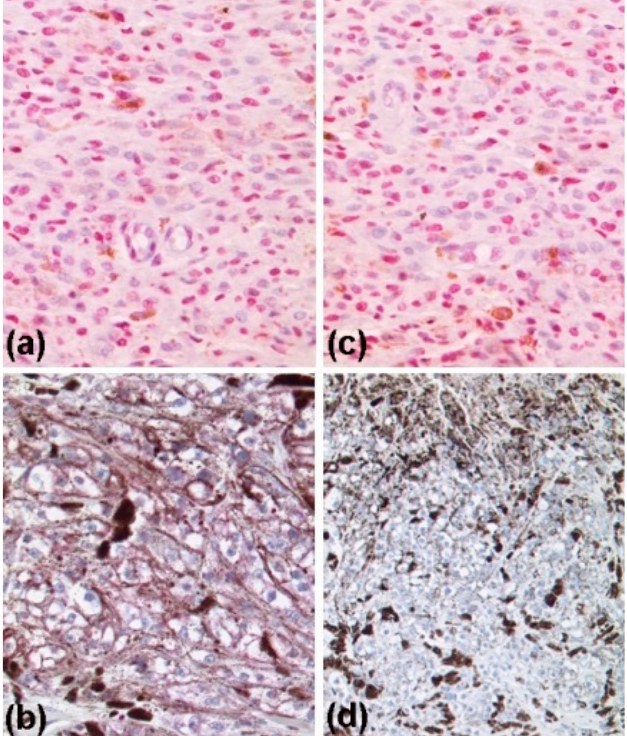
Figure 4. Immunohistochemitry of a tumor nodule revealing almost complete loss of H3K27me3 ( a , b ) and 5-hydroxymethylcytosine ( c , d ) expression in the malignant deep part ( b , d ) of the tumor when compared to the upper benign part of the melanocytic tumor ( a , c ).